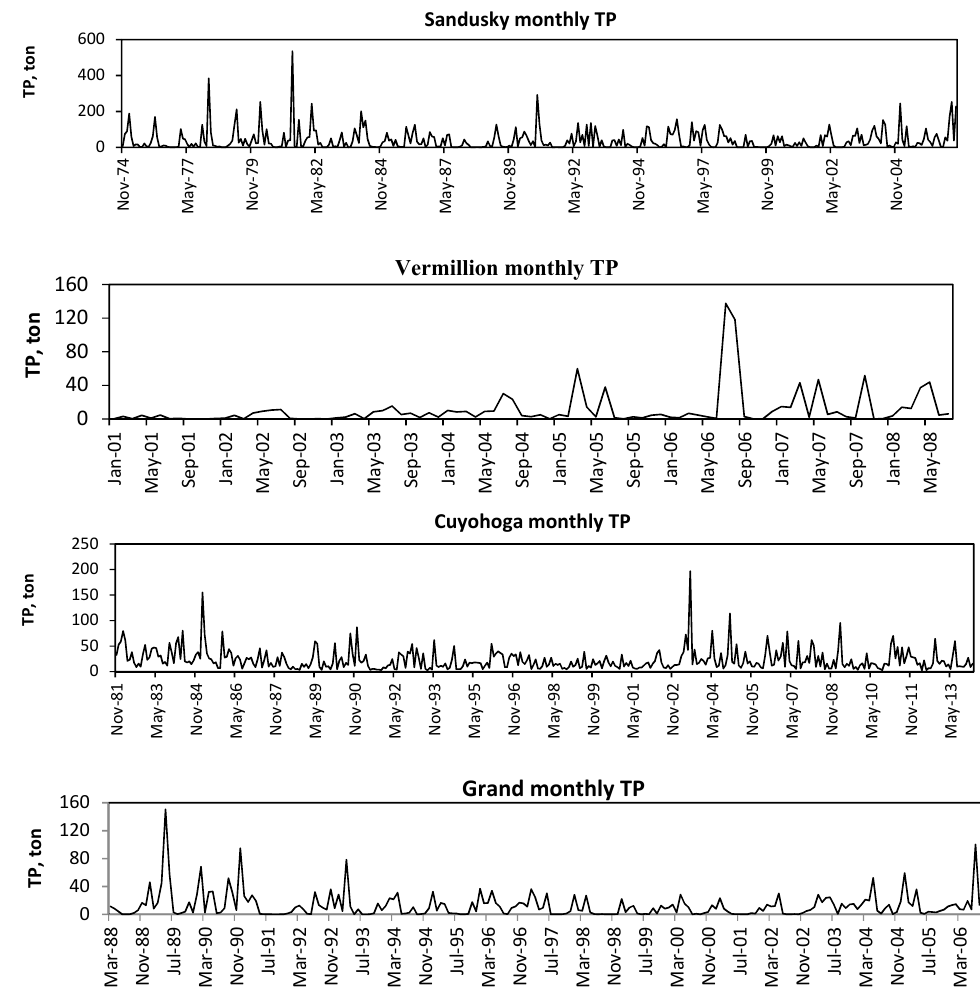
Figure 2. Monthly total phosphorus (TP) loading of the six watersheds used in the study.